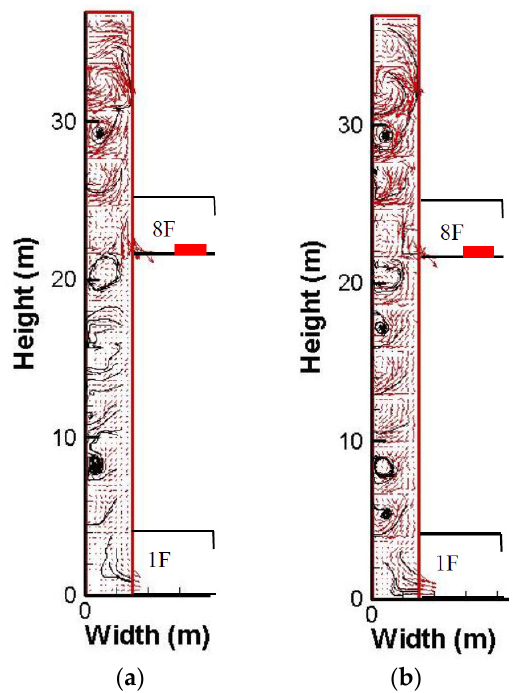
Figure 9. Velocity vector graph at 4 m/s: ( a ) 120 s and ( b ) 390 s.